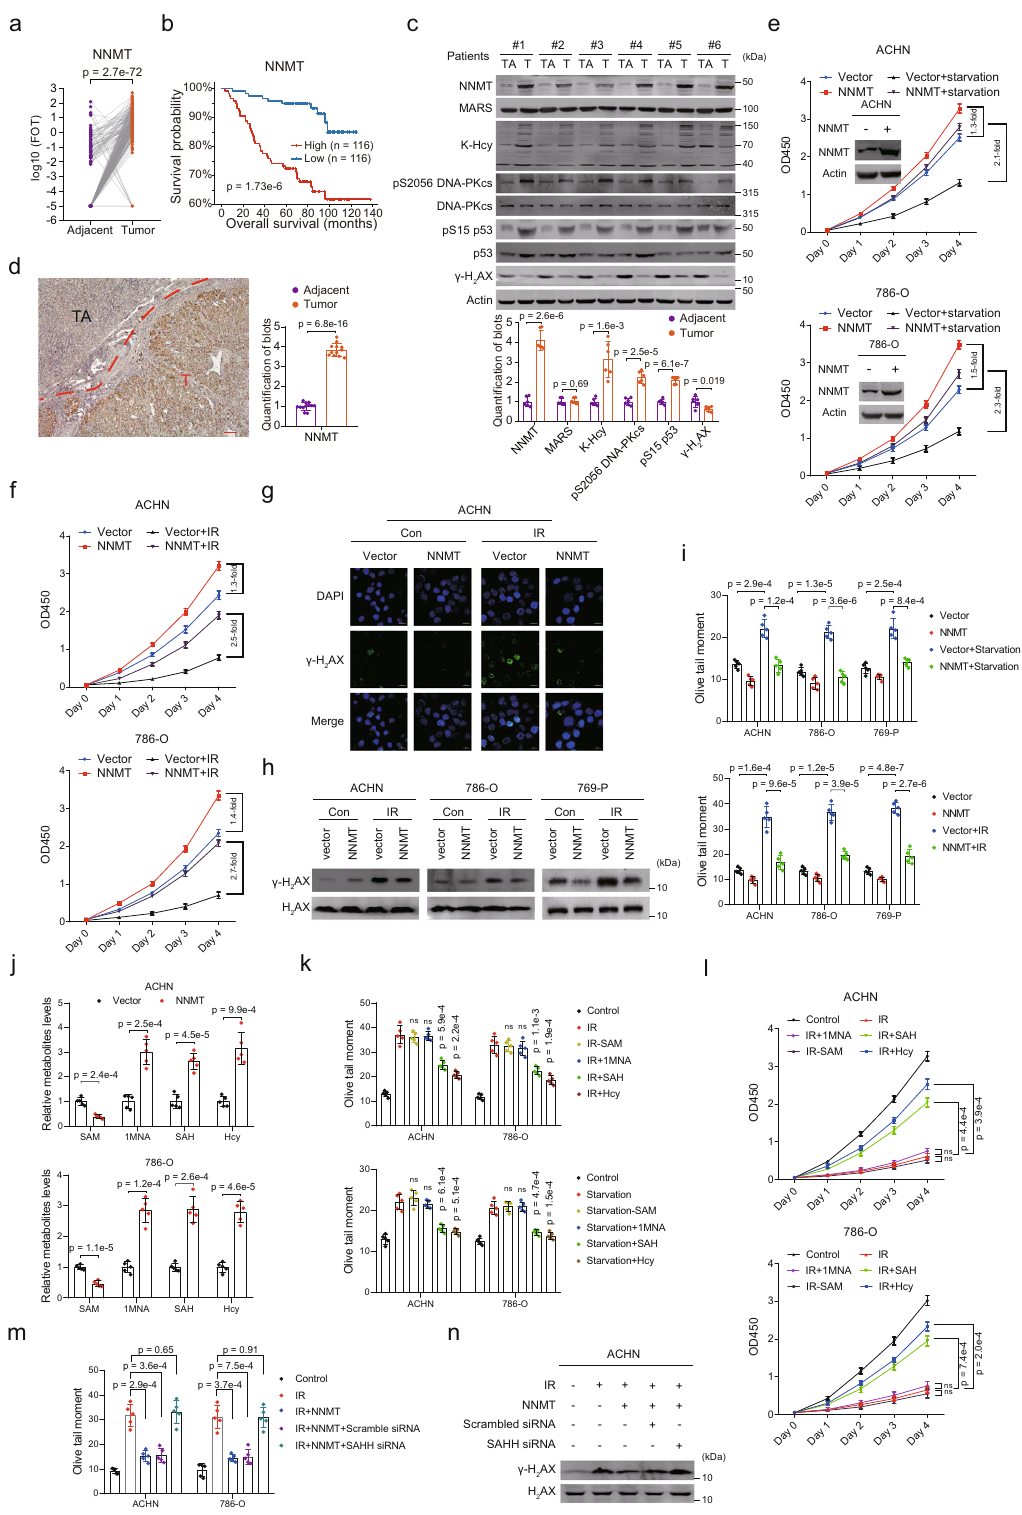
between DNA-PKcs and MARS was con fi rmed by co- immunoprecipitation assays using either exogenous DNA-PKcs and MARS in ACHN and 769-P cells (Supplementary Fig. 9a), or endogenous DNA-PKcs and MARS in 786-O cells (Fig. 7d). Ele- vated NNMT, SAH, Hcy, or MARS levels led to dose-dependent increases of DNA-PKcs homocysteinylation in ACHN and 769-P cells (Supplementary Fig. 9b – e). These results con fi rmed that DNA-